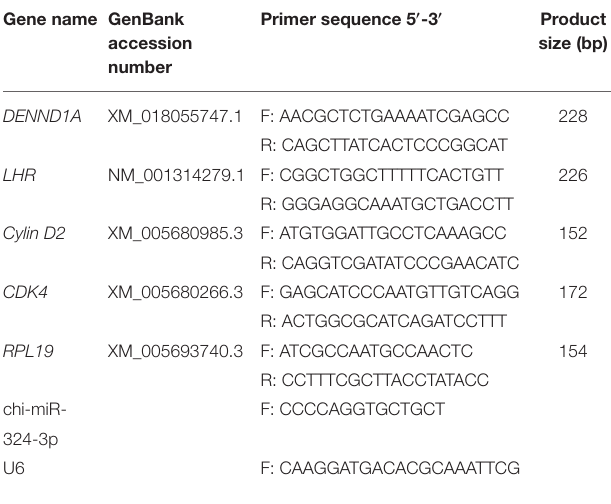
TABLE 1 | Primer sequences used for quantitative-polymerase chain reaction in this